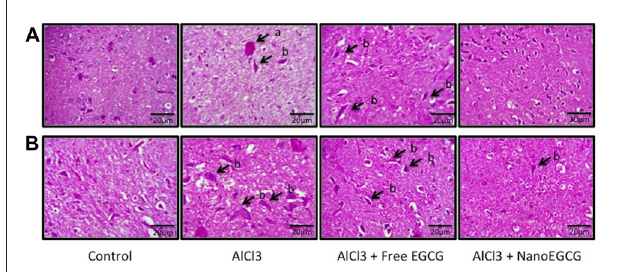
FIGURE 3 | Representative histopathology images in the (A) cortex and (B) hippocampus regions of the rat brain ( n = 3). Abbreviations: a, neuritic plaques and b, neurofibrillary